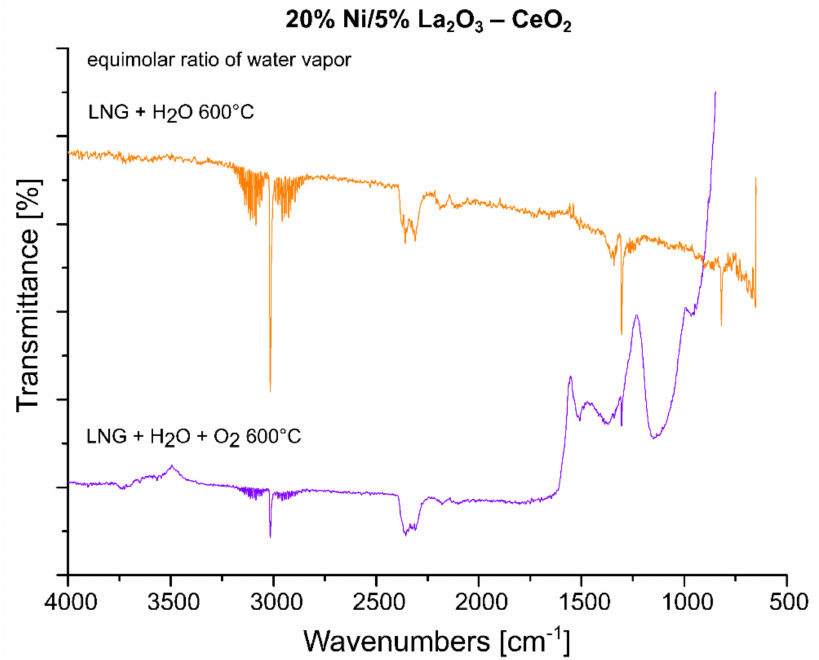
Figure 11. In situ IR spectra under steam and oxy-steam reforming of LNG conditions at 600 ◦ C with equimolar water vapor, recorded for the 20% Ni/5% La 2 O 3 –CeO 2